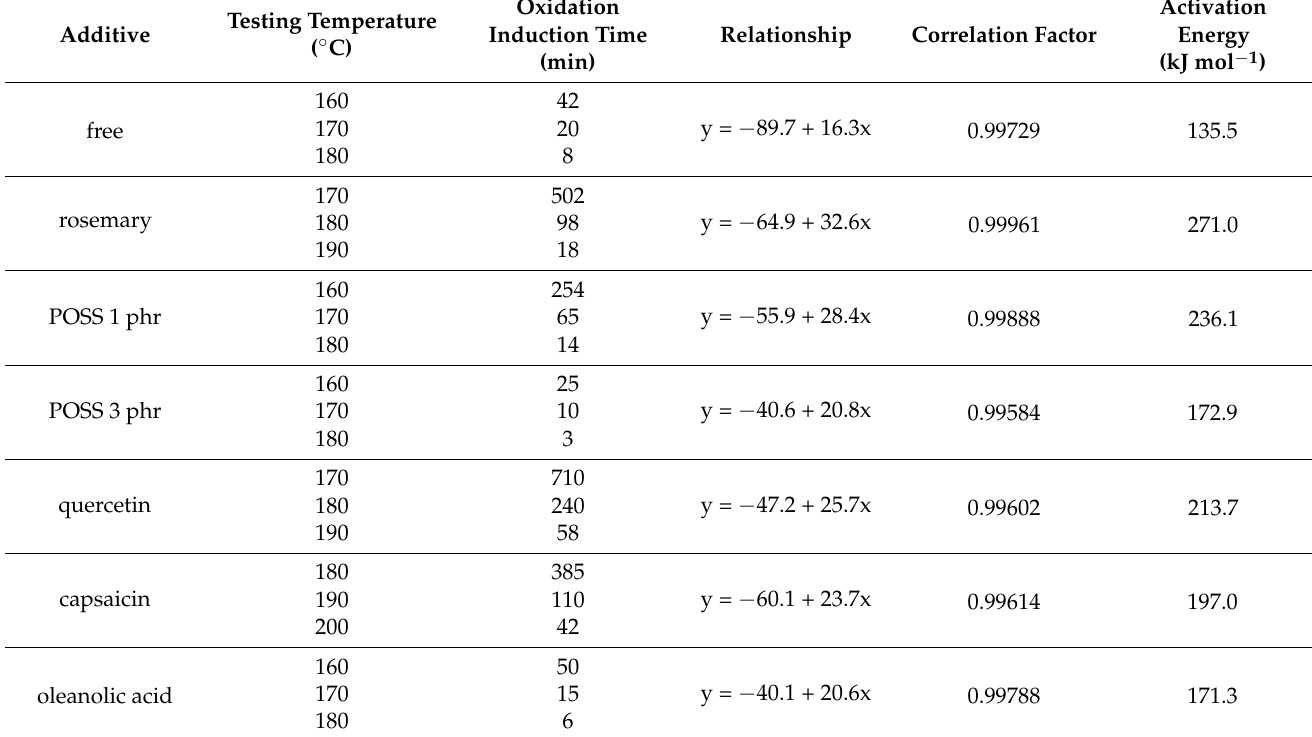
Table 2. The values of activation energies for the thermal stabilization of EPDM based on the values of oxidation induction times.